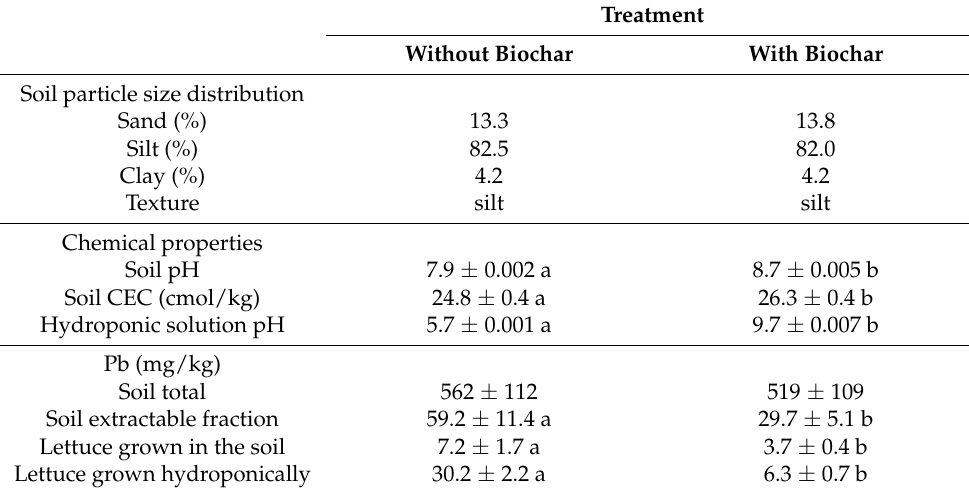
Table 3. Particle size distribution and mean ( ± standard error) of pH, cation exchange capacity (CEC) and total and extractable (bioavailable) Pb concentrations in the soil and in leaves of lettuce plants grown in the soil or hydroponically, with and without the addition of biochar. Different letters indicate statistically significant ( p < 0.05) differences.